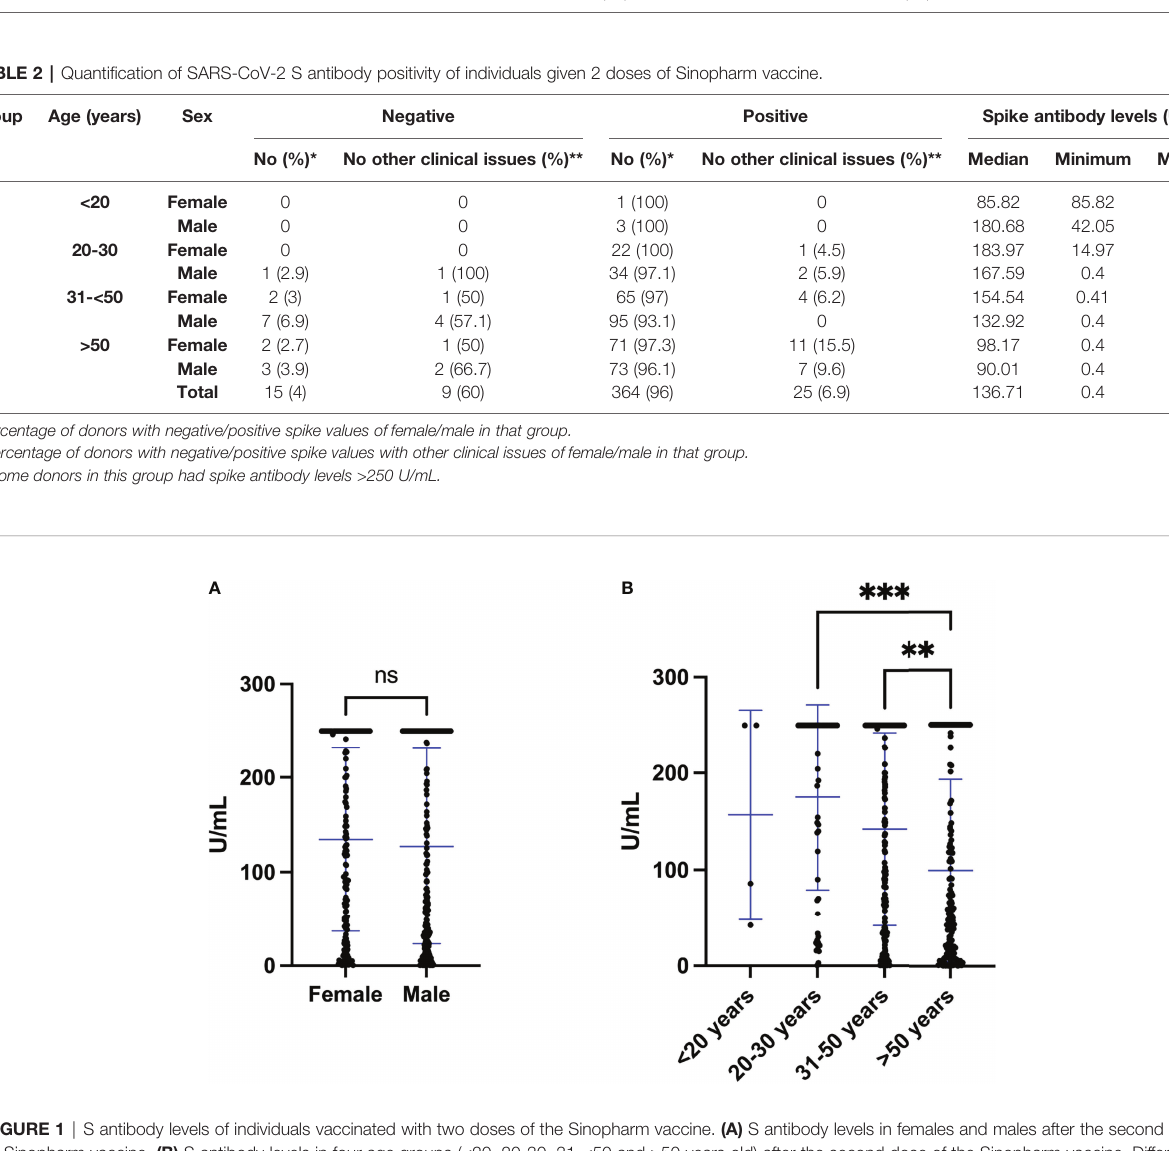
FIGURE 1 | S antibody levels of individuals vaccinated with two doses of the Sinopharm vaccine. (A) S antibody levels in females and males after the second dose of Sinopharm vaccine. (B) S antibody levels in four age groups (<20, 20-30, 31-<50 and >50 years old) after the second dose of the Sinopharm vaccine. Differences between genders and groups were assessed by (A) Mann Whitney test and (B) Kruskal-Wallis test, followed by post hoc multiple comparison test. The asterisks indicate **p value < 0.01 and ***p value < 0.001. ns, not signi fi